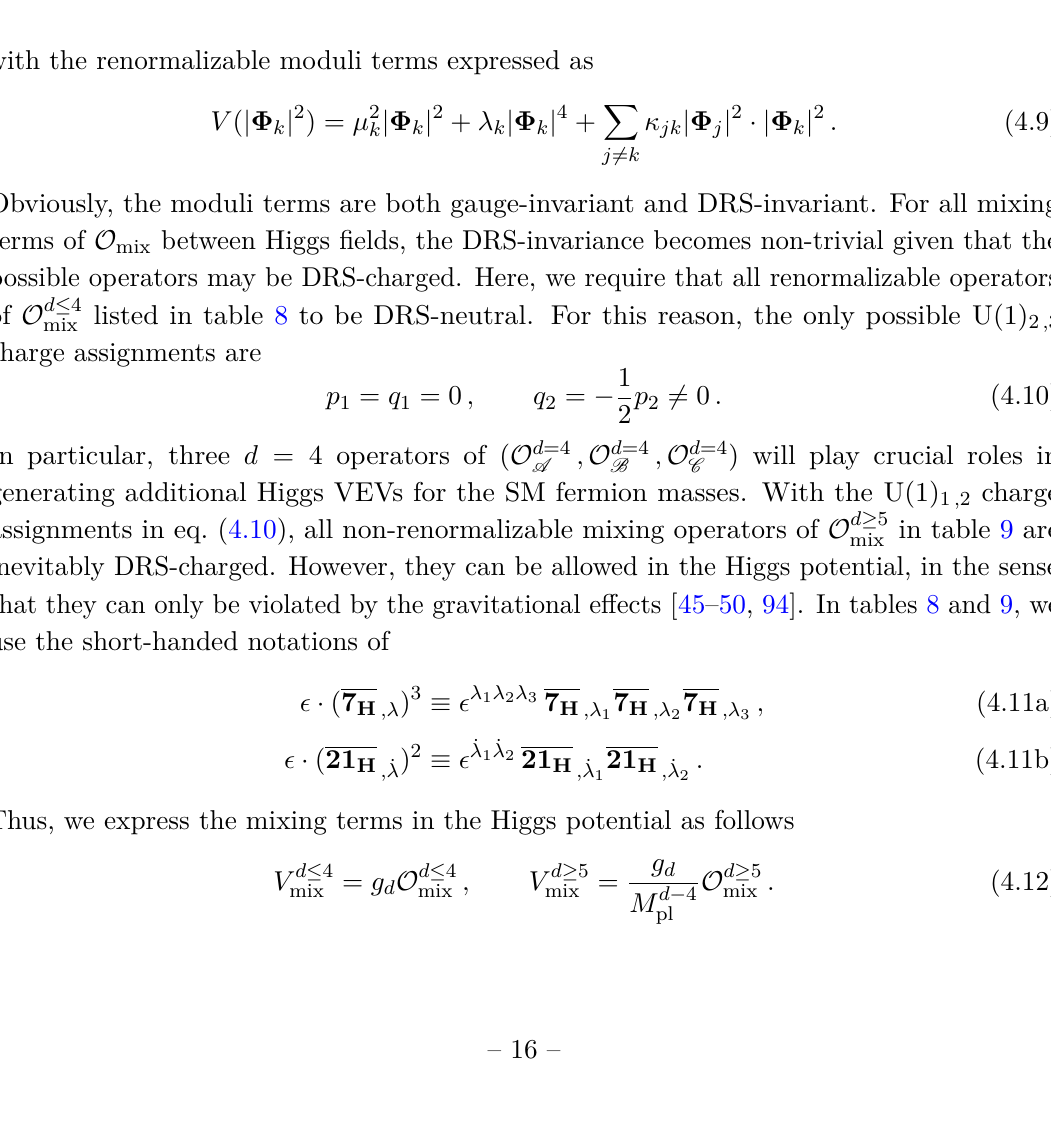
= q = 0 and q = − 1 p 2 6 = 0 are marked in 1 1 2 2